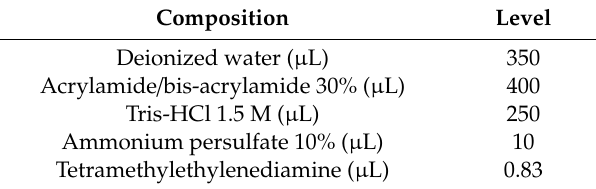
Table 3. The protocols used to prepare the gel used in protein